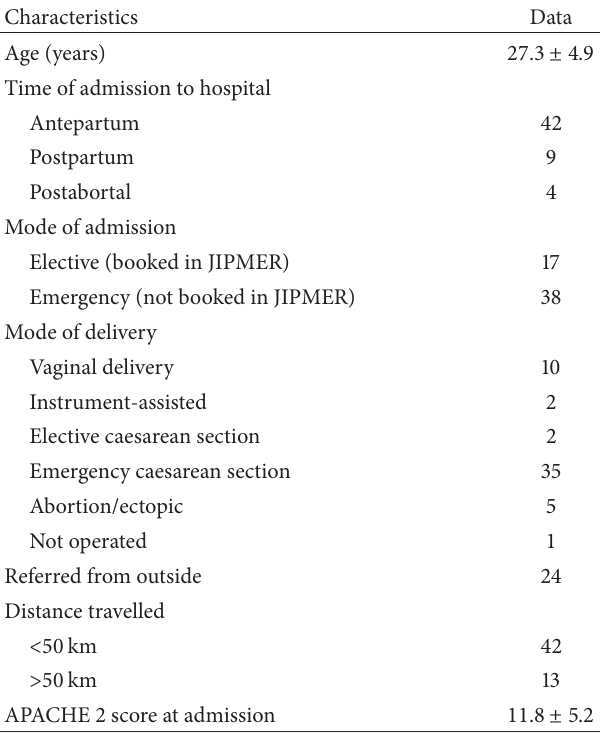
Table 2: Patient